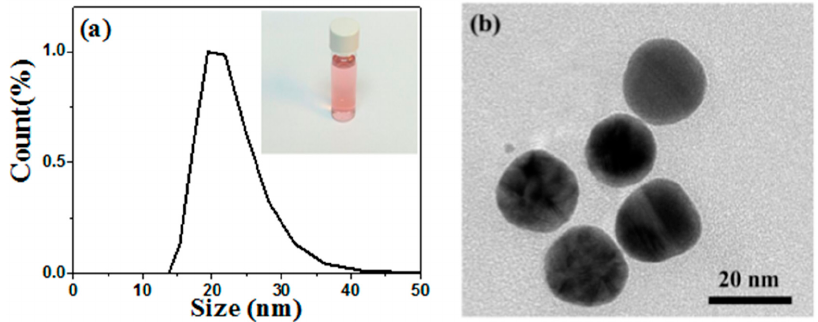
Figure 1. ( a ) Light scattering data for Au NPs size distribution, inset: Au NPs solution. ( b ) TEM image of Au NPs.